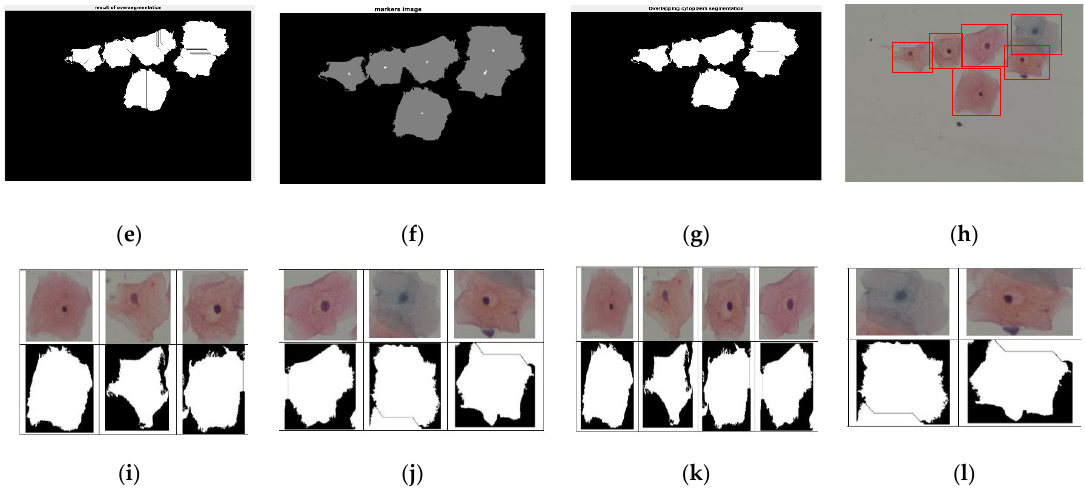
Figure 9. Results of the proposed cell segmentation algorithm. ( a ) Original color image, ( b ) Image of foreground objects, ( c ) Image of background objects, ( d ) Image of distance transformed, ( e ) Image of over-segmentation result without using markers, ( f ) Markers’ image, ( g ) Image of segmentation result by using markers’ image, ( h ) Image of boundary detection, ( i,j ) Image of cropping results, ( k ) Image of isolated or touching cells, and ( l ) Image of overlapping cells.